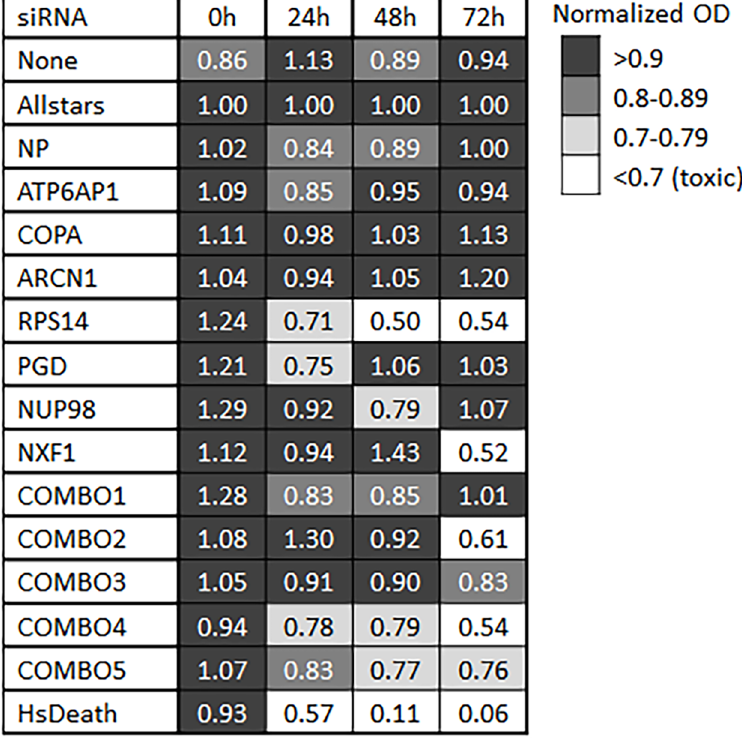
Fig 4. Cytotoxicity of siRNA treatment in NHBE cells. Cell viability of NHBE cells at 0, 24, 48, and 72 hours post siRNA transfection. Values are normalized to mean OD of cells transfected with non-targeting siRNA at each corresponding time interval after transfection. Relative values below 0.7 are considered toxic; all other values are considered viable, with those shaded in dark grey having the greatest cell viability ( > 0.9) and those in light grey being near the cutoff for cell viability (0.7 to 0.79).